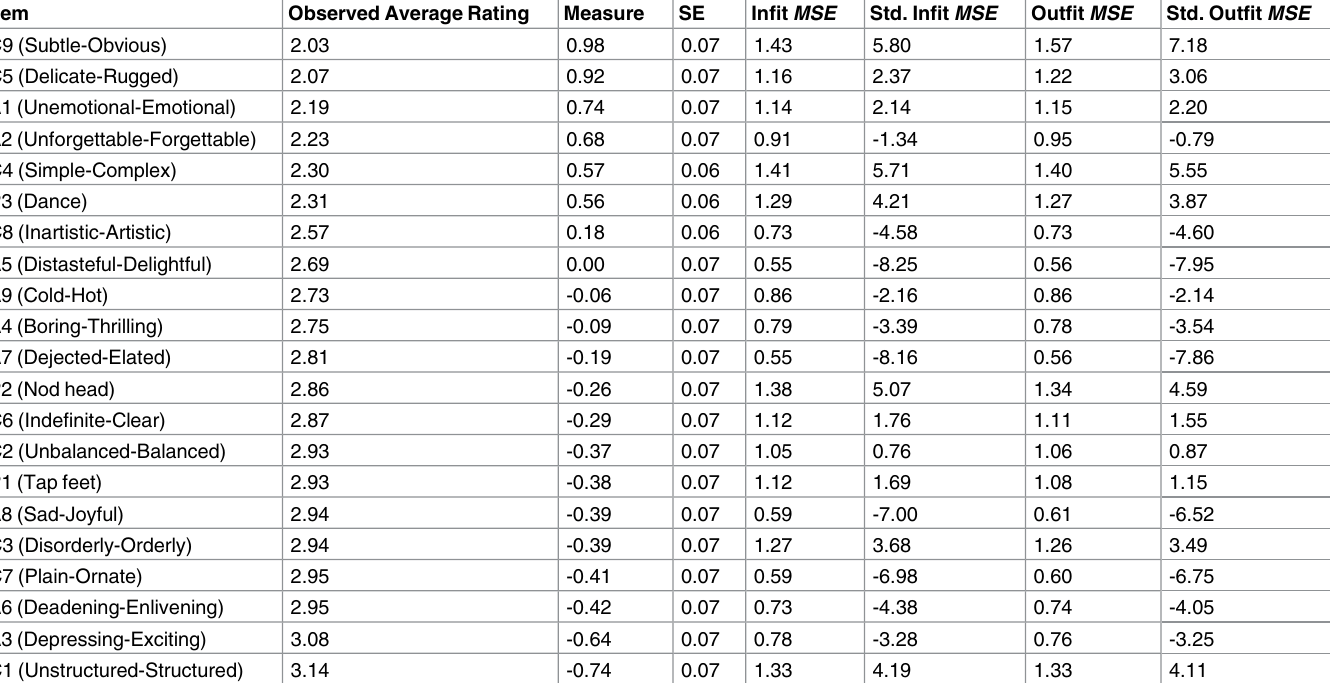
Table 4. Calibration of the Item Facet. Items (C = cognitive, A = affective, P = psychomotor) are ordered by their endorsability. Most difficult item to rate (C9) on top, easiest (C1) on bottom. C, A, and P items are mixed in their ratings and spread across the logit scale. Item